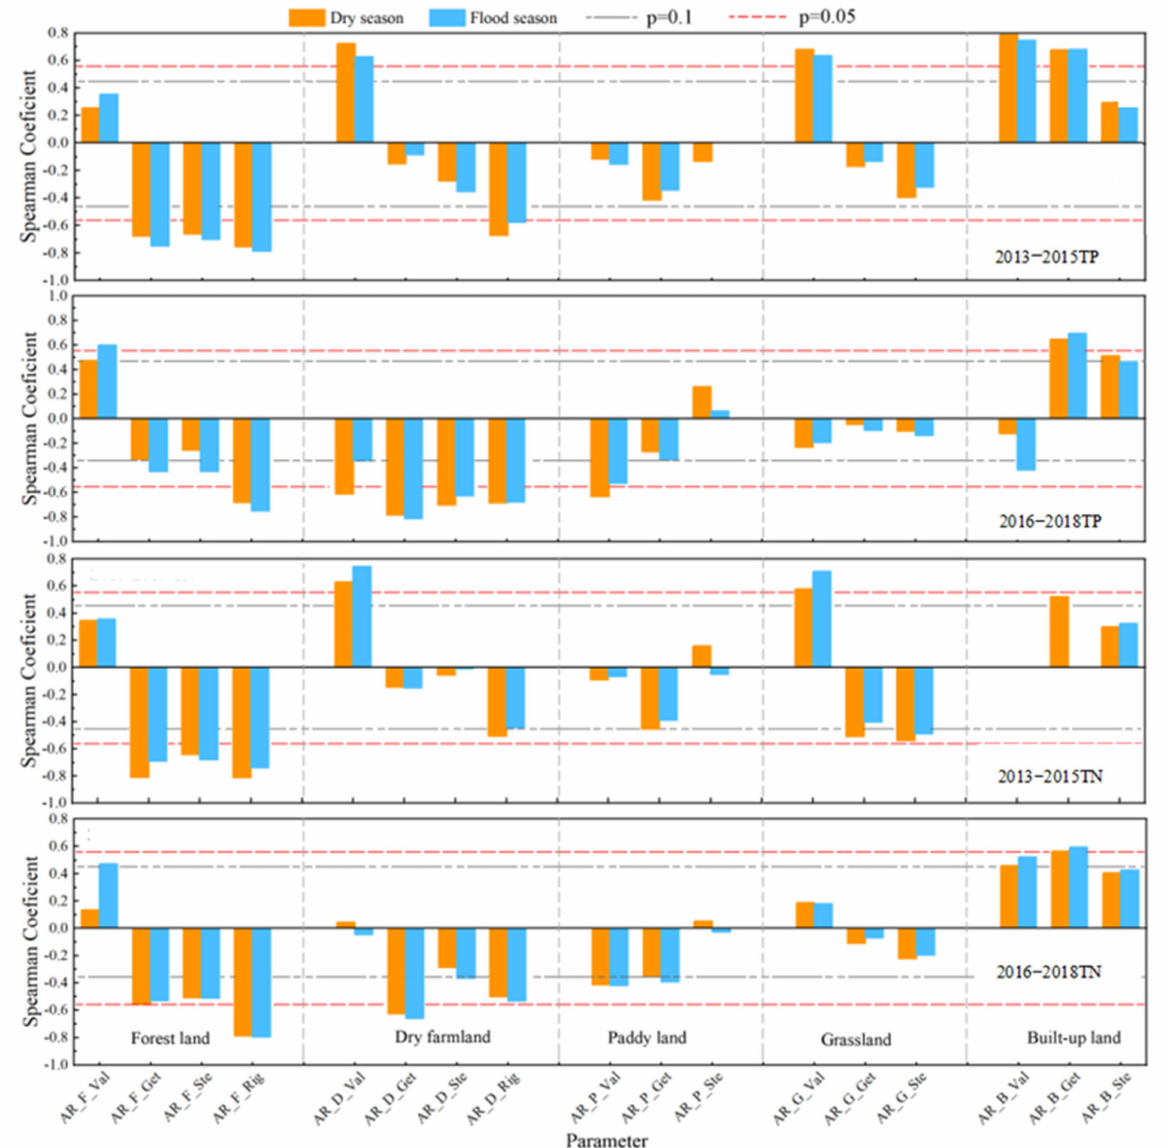
Figure 17. Correlations between land use structures and TP and TN concentrations on different topographic